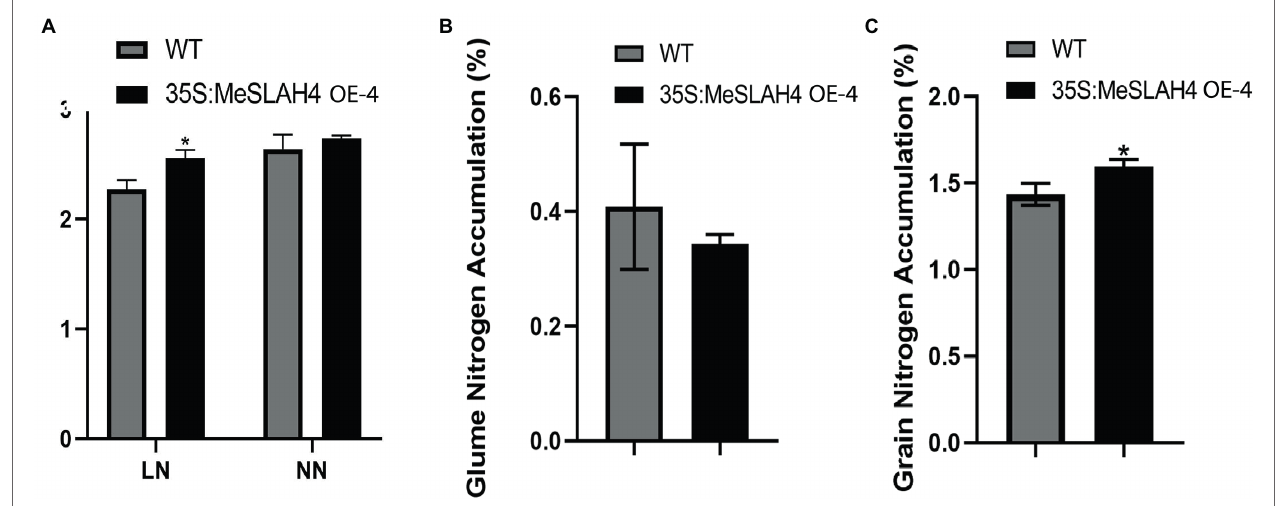
FIGURE 7 | Nitrogen accumulation in whole plants, grain, and glume in rice. (A) Nitrogen accumulation in whole rice plants. LN, 0.01 mm NH 4 NO 3 ; NN, 0.5 mm NH 4 NO 3 . (B) Nitrogen accumulation (%) in glume. (C) Nitrogen accumulation (%) in grain. The error bars indicate standard deviations and the data are shown as mean values ± SD, while * represents significant differences at p < 0.05 on one-way ANOVA